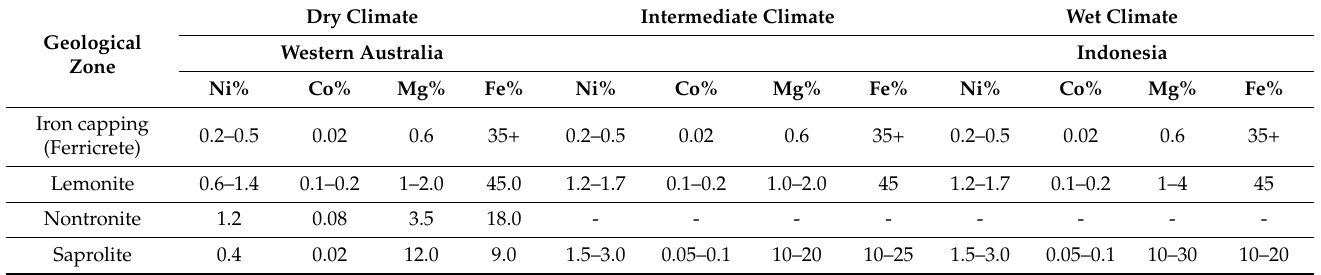
Table 2. Laterite classification, according to its geological structure, and chemical analysis